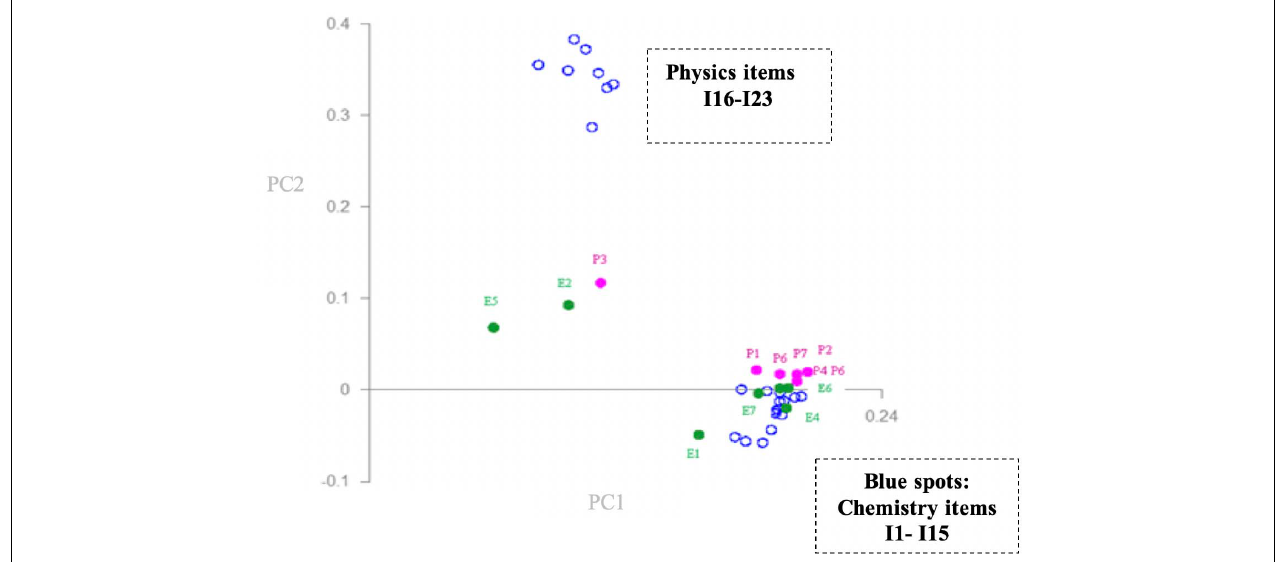
FIGURE 5 | Results of the PCA on considered aspects related to teacher and students and positive emotions: Loadings plot for the principal components 1 and